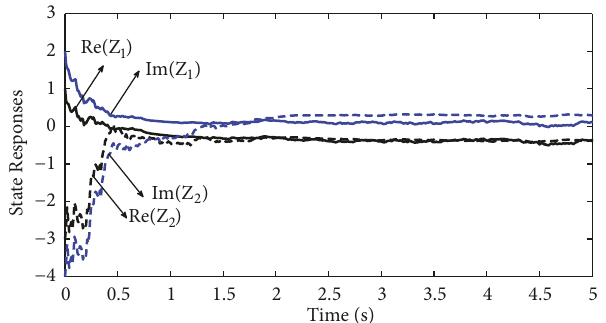
Figure 3: State curves of the real parts and imaginary parts in (48) with stochastic term.